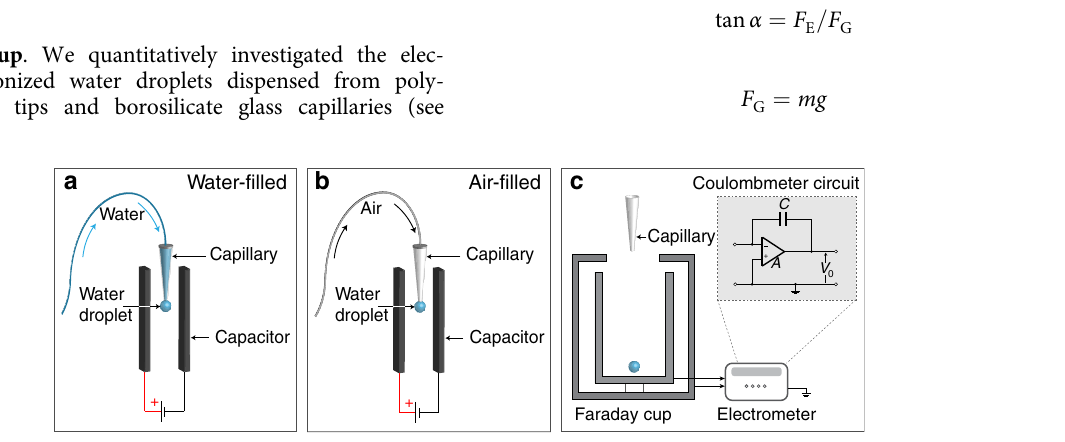
Fig. 1 Schematics of the experimental set-ups. a Droplets formed at the tip of a water- fi lled capillary (hydrophobic or hydrophilic) inside a parallel plate capacitor. b Droplets formed at the tip of an air- fi lled capillary. c Direct measurement of electrical charges carried by water droplets using a Faraday cup (comprising aluminum sheet) connected to an electrometer. The inset demonstrates the circuit of the electrometer, where C , V 0 , and A refer to the capacitance, the voltage across the capacitor, and a low current input ampli fi er, respectively 76